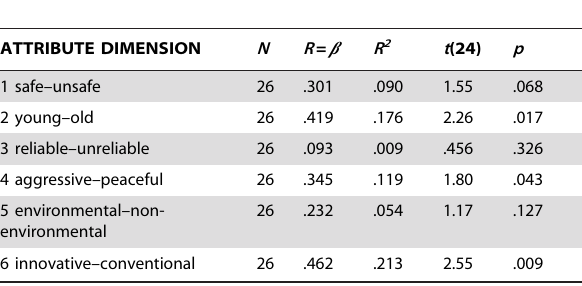
Table 7. Study 2: Estimates of convergent validity (simple linear regressions for all six dimensions).